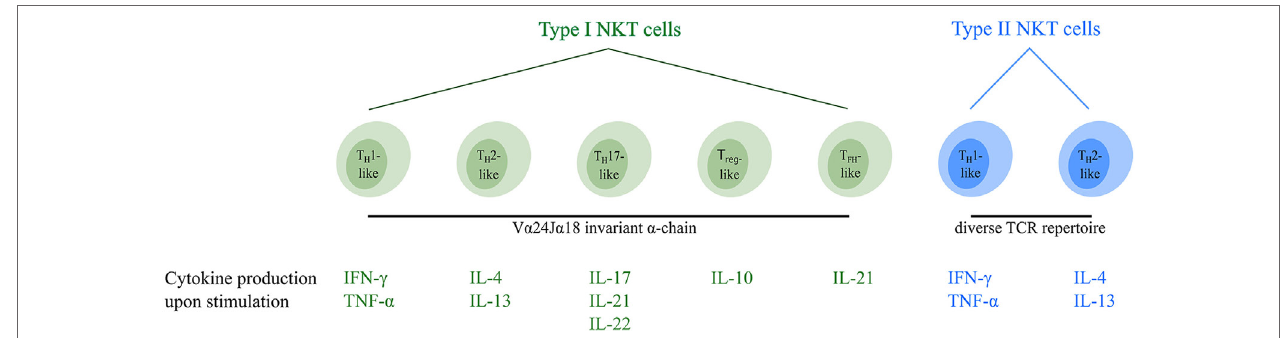
FigURe 1 | Overview of the different functional human NKT cell subsets. CD1d-restricted human NKT cells can be divided into subsets based on their TCR repertoire and cytokine profile. Type I NKT cells express the invariant V α 24J α 18 TCR α -chain and can be subdivided into five distinct functional subsets (indicated in green). In addition, type II NKT cells express a diverse TCR repertoire and can be subdivided into two functional subsets (indicated in blue). Upon activation, NKT cells secrete a unique pattern of cytokines, indicated for each subtype. Type I and type II NKT cells are able to switch between different functional subsets upon interactions within the TME. Abbreviations: NKT, natural killer T; TCR, T cell receptor; T H , helper T; T reg , regulatory T; T FH , follicular helper T; TME, tumor